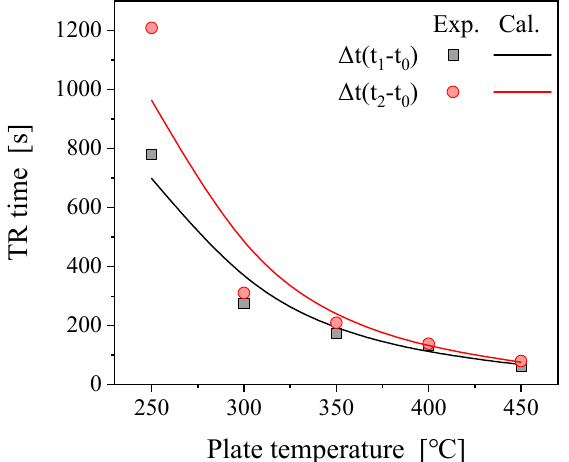
Figure 6. Comparison between experimental results and reaction kinetic prediction.